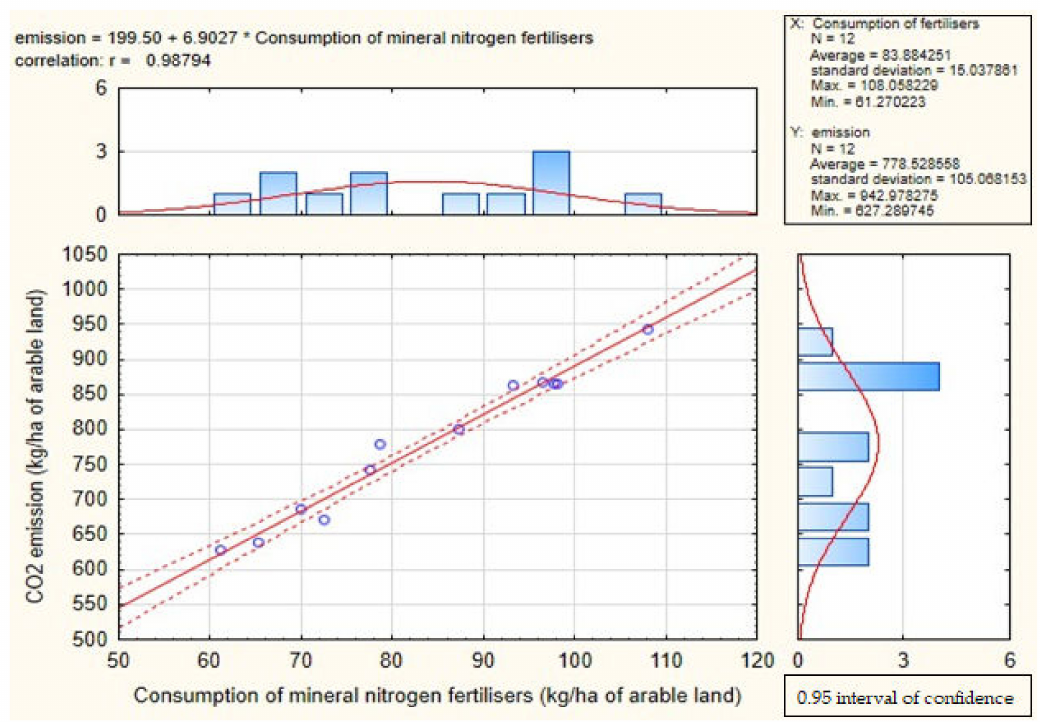
Figure A5. Results of correlations analysis: Hungary. Source: own calculation based on Eurostat. Note: purple dot: observation, red solid line: linear function, red dashed lines: 95% interval of